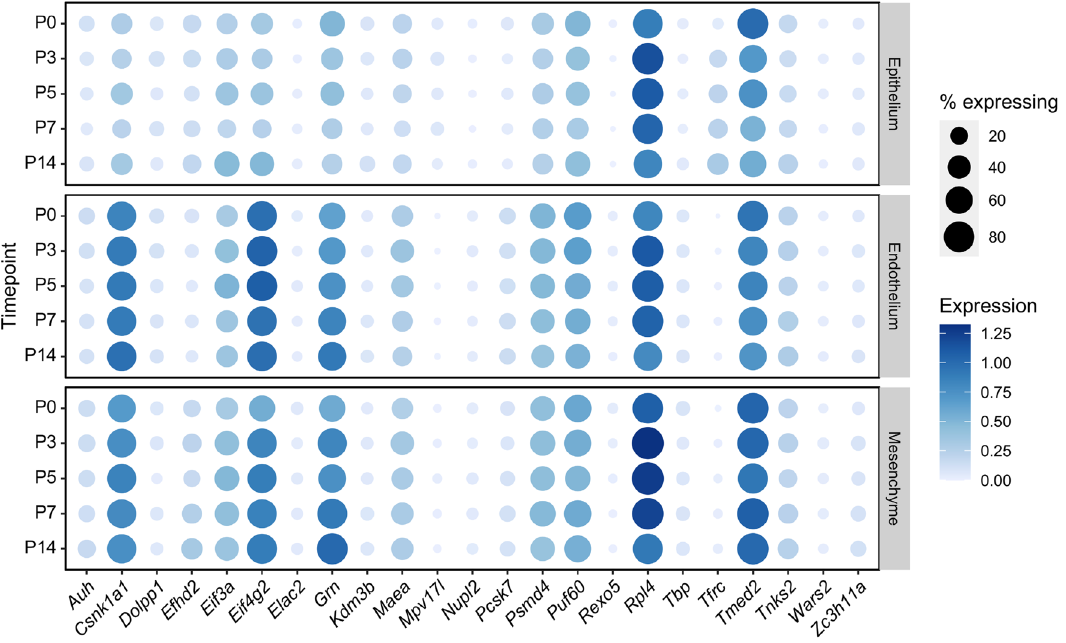
Figure 1. Profile of reference gene expression time in the developing lung by single-cell RNA sequencing. Using a recently published single-cell sequencing atlas of the developing mouse lung 18 , gene expression of the different candidate reference genes in broadly categorized cell types (epithelial, endothelial and mesenchymal cells) was analyzed over time. The average expression in each cell type at each timepoint is plotted in a dotplot. The size of the circle indicates the fraction of cells with expression levels above the limit of detection and the intensity of the color of the circles indicates the average expression level in each cell. Larger circles indicate a greater fraction of cells with detectable expression and darker circles indicates greater average